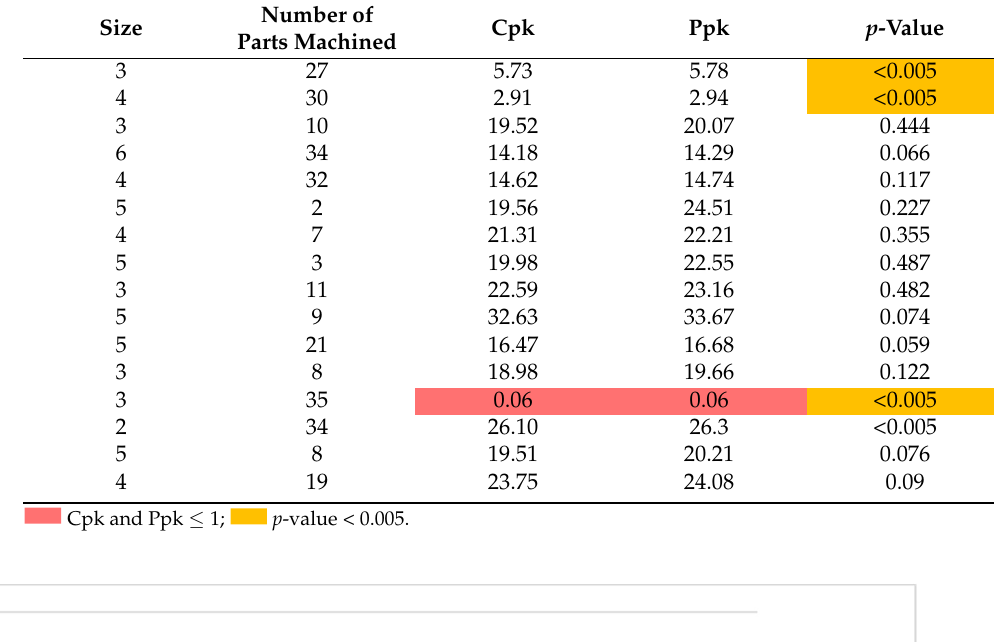
Table 6. Normality and capability analysis based on size.